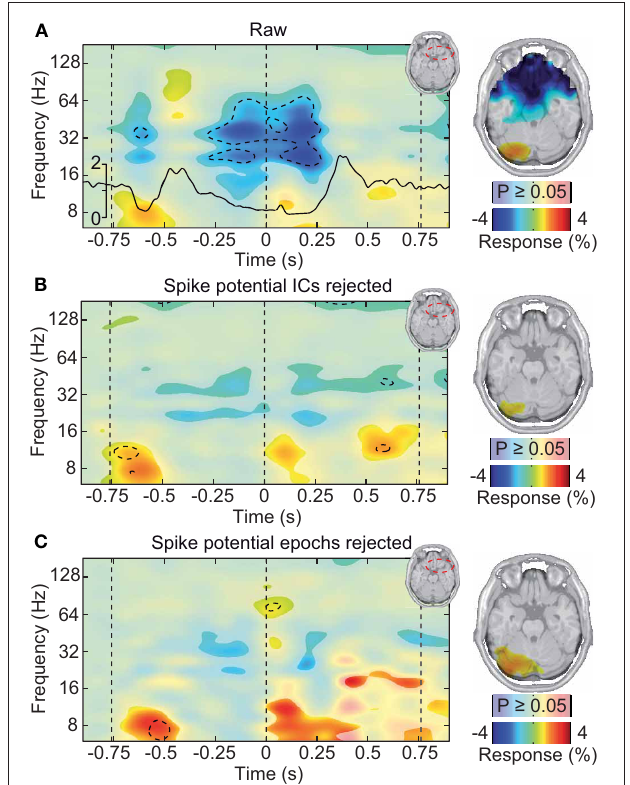
FIGURE 7 | Saccadic spike artifact at the source level. (A) Left: change in signal power relative to prestimulus baseline in a frontal volume of interest in the vicinity of the ocular muscles (see upper right inset). The black line shows the concurrent microsaccade rate (compare Figure 5A ). Statistically significant differences are indicated by saturated colors ( t -test, p < 0 . 05), and by contour lines ( t -test, p < 0 . 05, Bonferroni corrected for time and frequency). Right: spatial distribution of signal power in the time-frequency range − 0.25 to 0.25s and 30–70Hz, overlaid on an axial slice. EEG signals were cleaned for muscle activity but not for microsaccadic artifacts. (B) Same as in (A) , but after removal of microsaccadic artifacts using ICA. (C) Same as in (A) , but after removal of microsaccadic artifacts using epoch